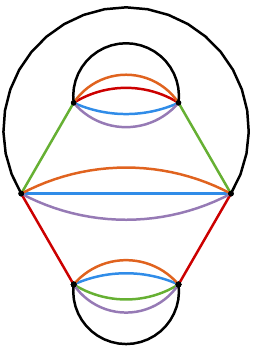
Figure 5. Two examples of vacuum 6-colored graphs.